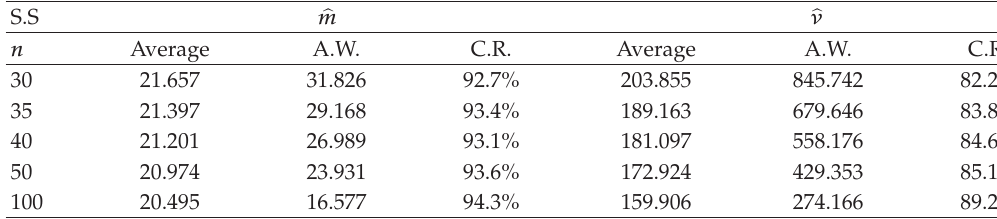
Table 3: Grouped data: τ 1 (cid:8) 0, τ 2 (cid:8) 1 . 5, τ 3 (cid:8) 3, τ 4 (cid:8) 4 . 5, τ 5 (cid:8) 6.